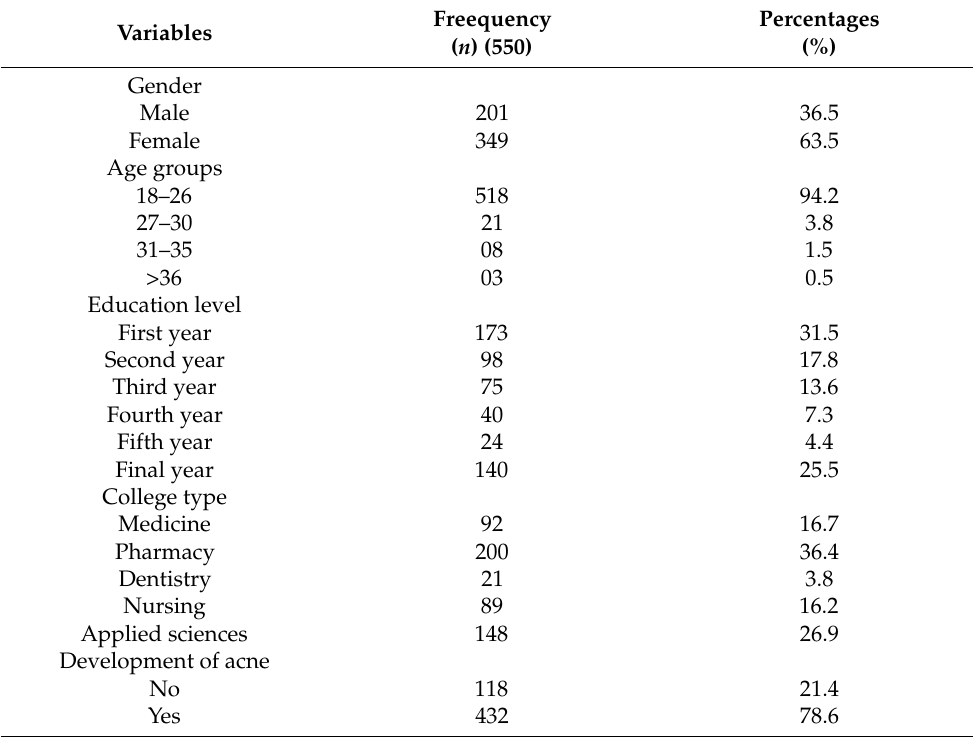
Table 1. Demographic and pathological characteristics of Saudi health care